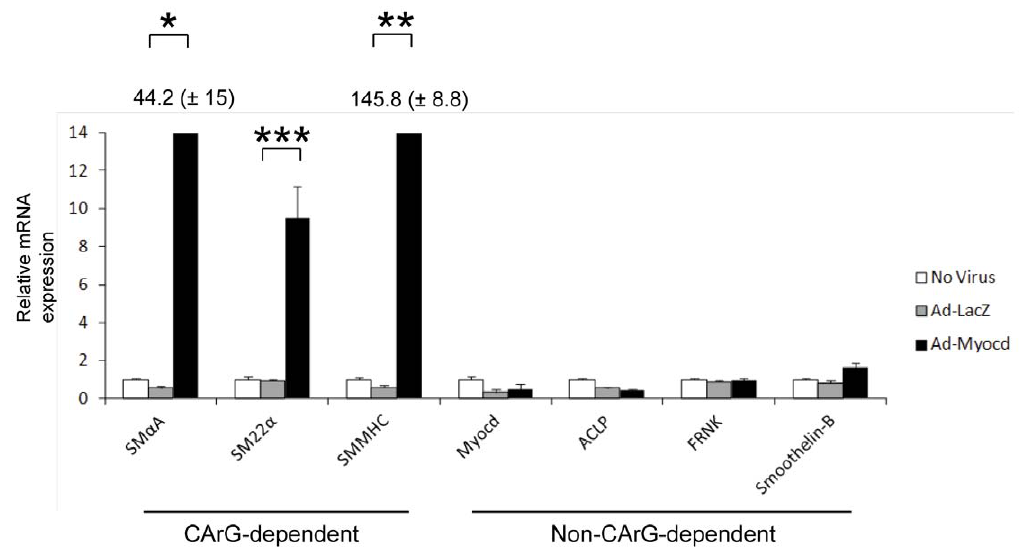
Figure 4. Selective upregulation of CArG-dependent genes by myocardin. Embryoid bodies were treated with no virus, Ad-LacZ or Ad-Myo from day 10 to day 28 and then harvested for RNA. SMC marker expression for a range of CArG-dependent and non-dependent genes was measured using real time RT-PCR and is normalised by three housekeeping genes and then presented relative to no virus controls. RT-PCR data represent means from at least three independent experiments. Error bars represent s.e.m. SM a A and SMMHC expression levels in response to myocardin were significantly higher than the other genes and thus the precise levels are depicted by numbers above the black bars ( 6 s.e.m.).